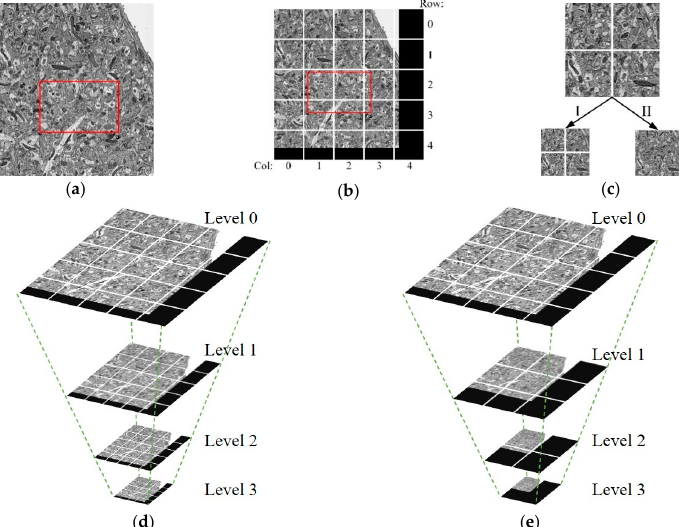
Figure 2. The designed image data model. ( a ) Suppose that the image in the viewport (the red box in the figure) is needed. Before the image is divided into blocks, the whole image needs to be obtained. ( b ) After the image is divided, only six small images need to be acquired; the block size is fixed, the undersized image blocks are filled with the black area. ( c ) Two downsampling methods: Method I: mipmap [37], before and after downsampling, the number of the image blocks is the same, but the image block size is reduced by four times; Method II: after downsampling, the image size remains unchanged, but the number of images is reduced. ( d) The image pyramid generated by Method I used to obtain images at di ff erent resolutions. ( e ) The image pyramid generated by Method II; compared with Method I, the number of image blocks needed to be acquired in this method is less when acquiring low-resolution (high-level)